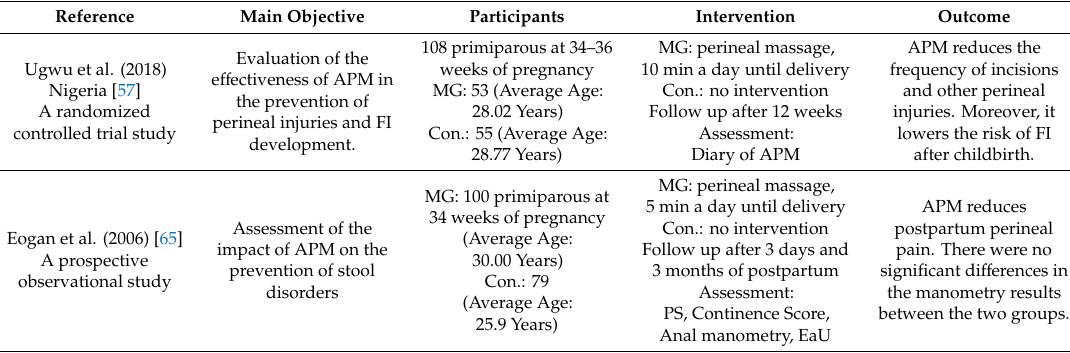
Table 5. Studies assessing the role of antenatal perineal massage in fecal incontinence